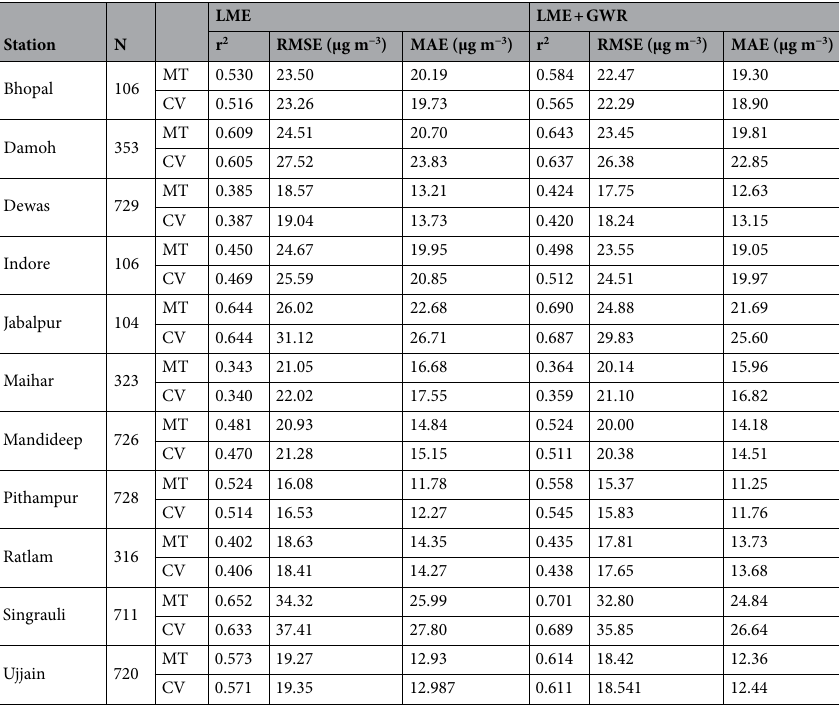
Table 3. Summary statistics of LME and LME + GWR mode (MT is model training and CV is cross validation).